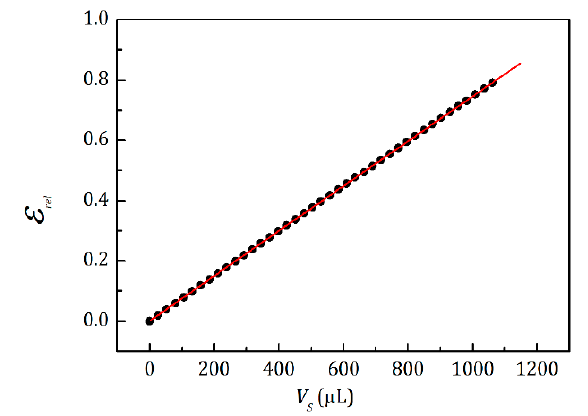
Figure A3. Calculated dependence of V S on ε rel , assuming a sample with constant temperature T 0 and volume V S = π R 2 L S at the bottom of the chamber. Red line is a fitted curve using a power law ε = a × V b , where a = (7670 ± 7) × 10 − 7 and b = 0.9959 ± 0.0 001. f = 232 Hz.